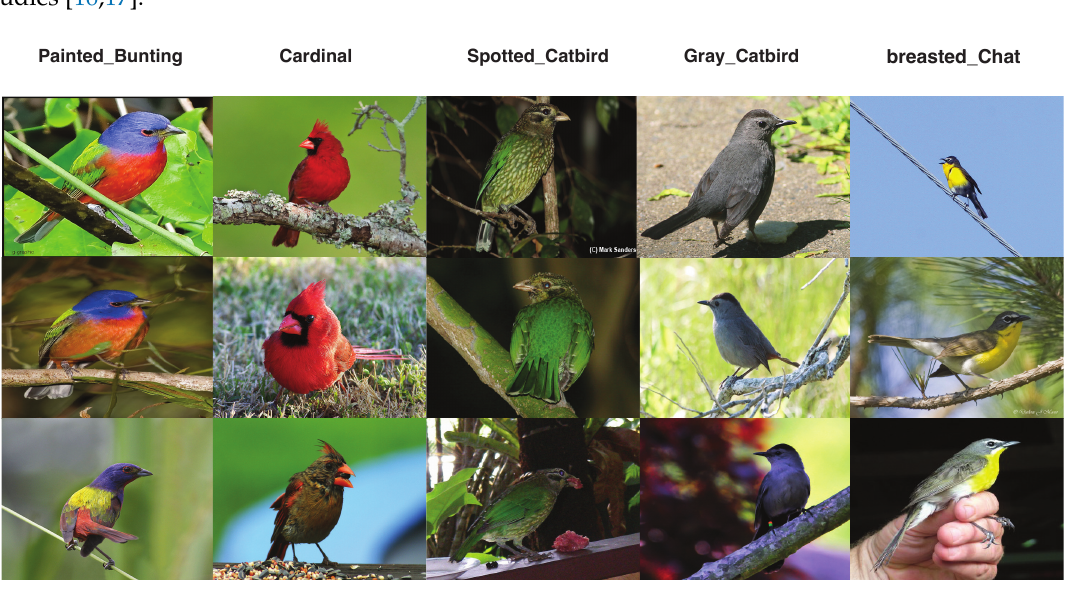
Figure 2. CUB200-2011.We selected three images from different